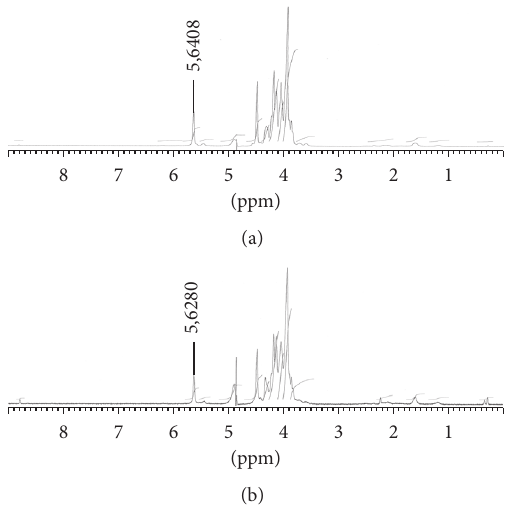
Figure 2: 1 H NMR spectra of alkali-soluble water-insoluble polysaccharides (ASPs) obtained from fruiting body (a) and vege- tative mycelium (b) of C. unicolor .